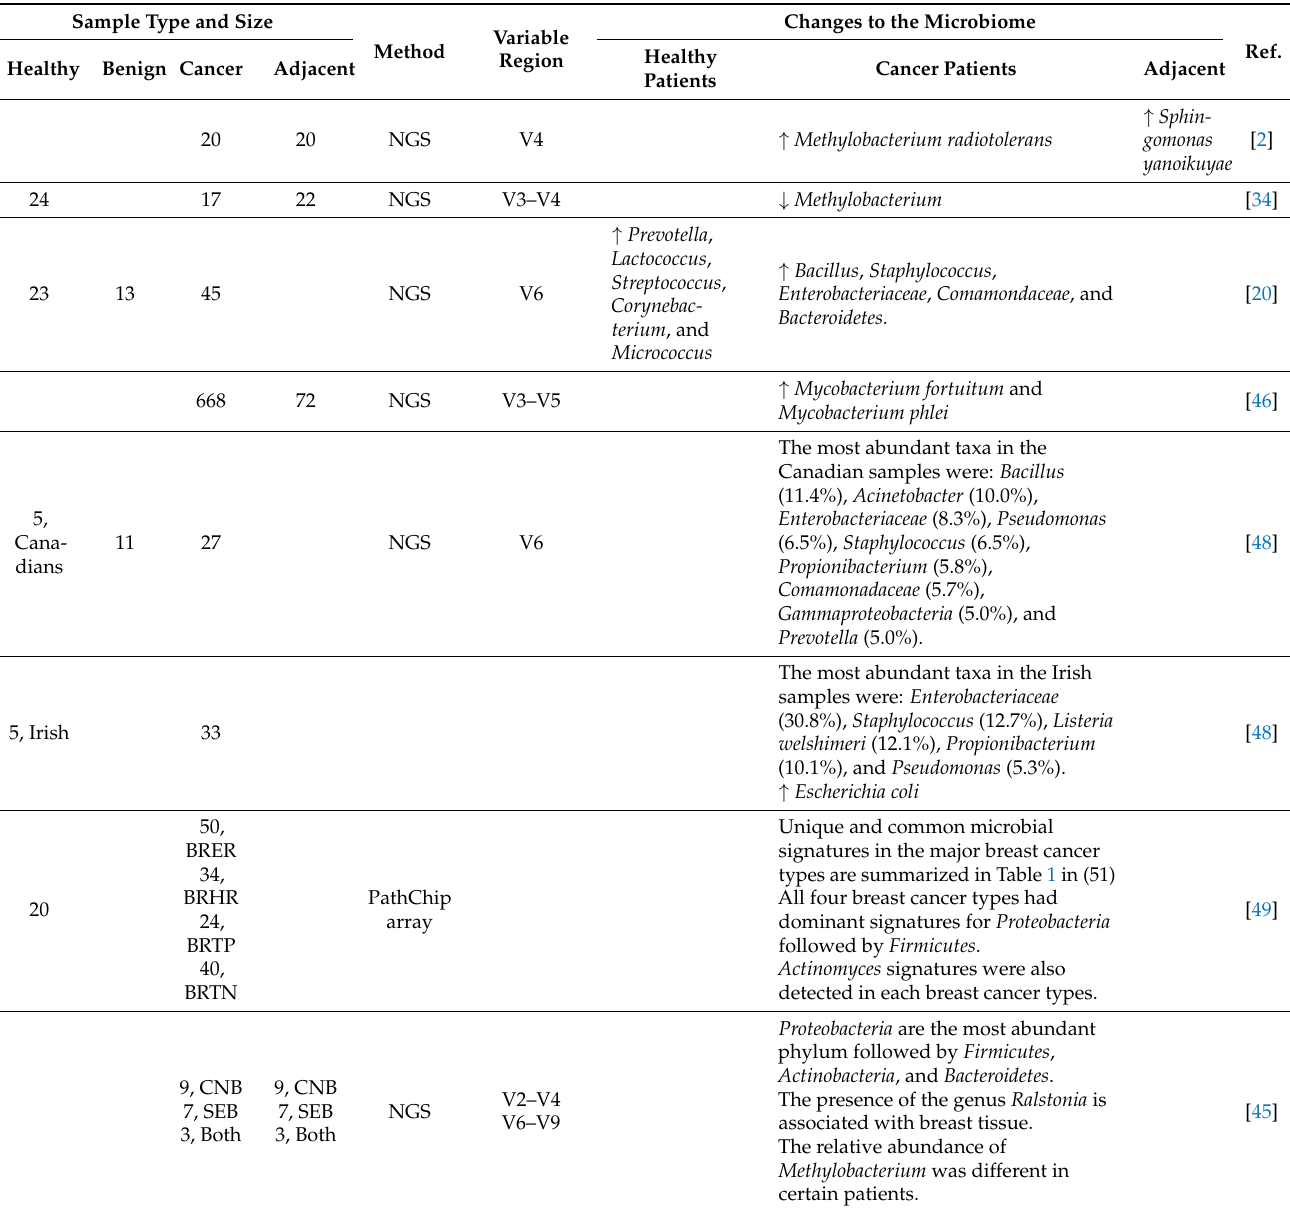
Table 1. Summary of studies investigating the alteration of breast tissue microbiome in breast cancer. Sample Type and